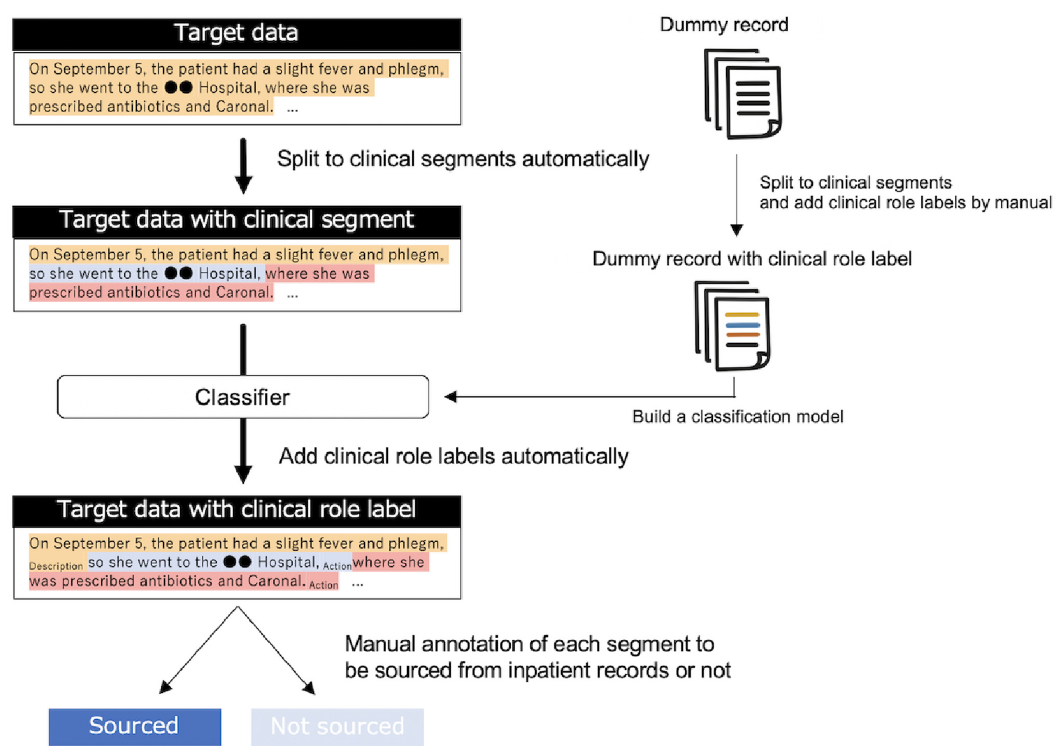
Fig 1. Proposed framework of our study. The colored blocks in the dummy record represent the clinical segment developed in previous study, where the sentence is split by medical sense [20].